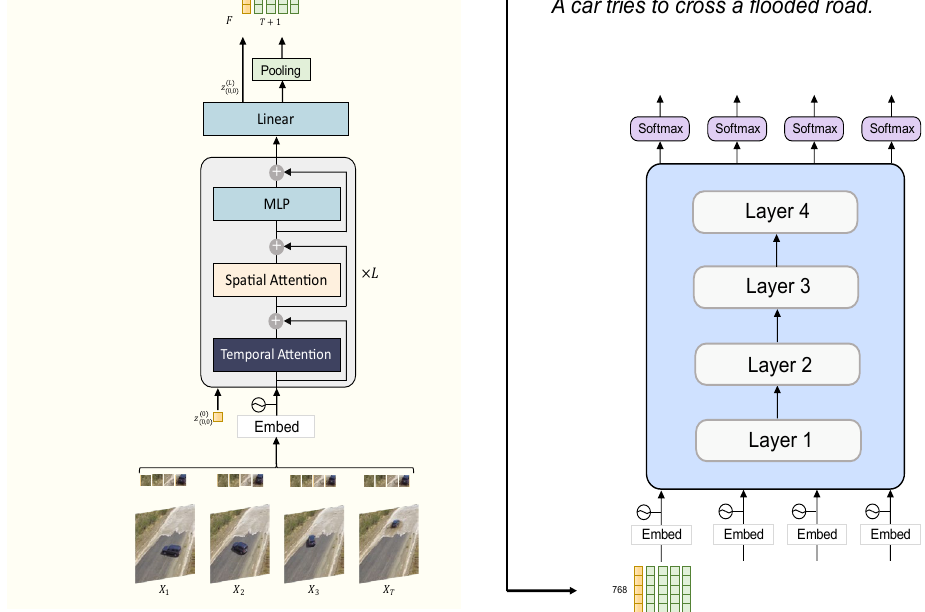
Figure 4. An illustration of the second configuration of the proposed captioning framework for CapERA dataset. The figure illustrates the example of sampling four frames from a video ( T = 4). These frames are embedded and augmented with positional information and then encoded using a video encoder that employs spatial and temporal attention.